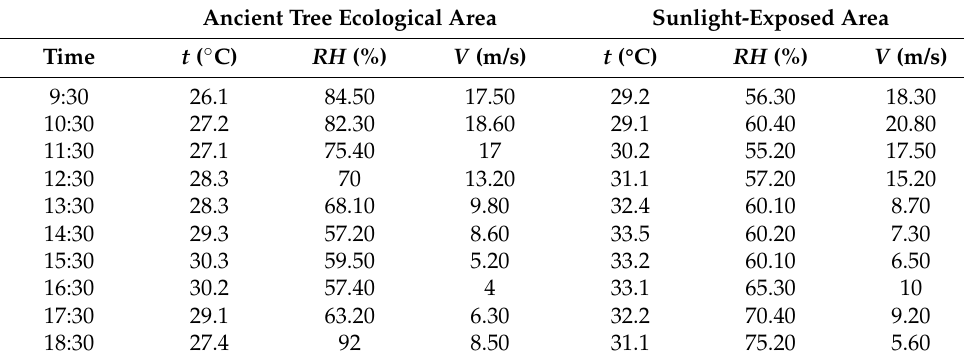
Table 1. Related data of somatosensory sense and